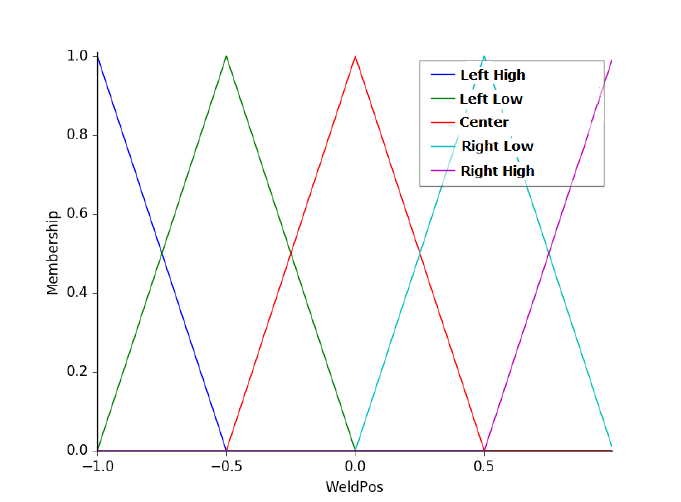
Figure 9. Membership functions of the variable WeldPos.